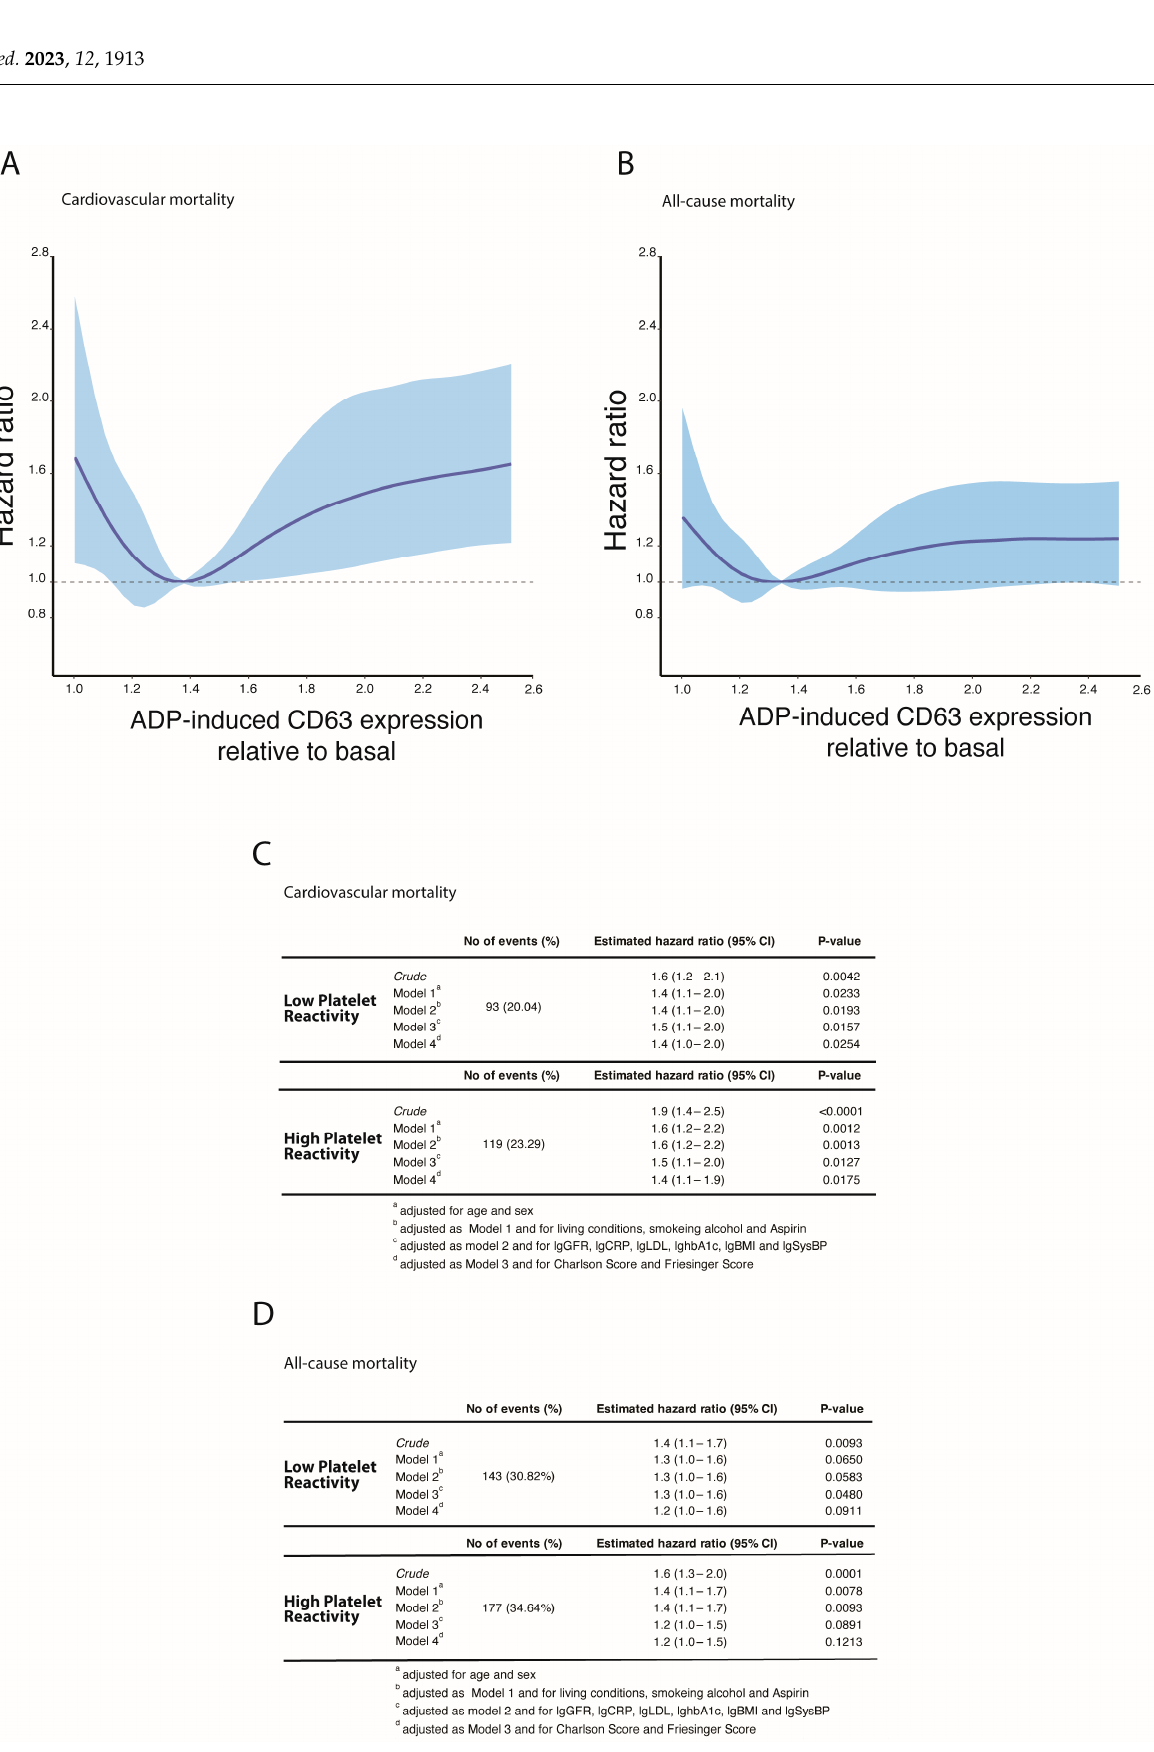
Figure 1. Platelet reactivity and cardiovascular and all-cause mortality in the LURIC study. Associ- ation between ADP-induced CD63 expression and cardiovascular and all-cause mortality in 1520 patients. ADP-induced CD63-expression was modeled with restricted cubic splines for the hazard